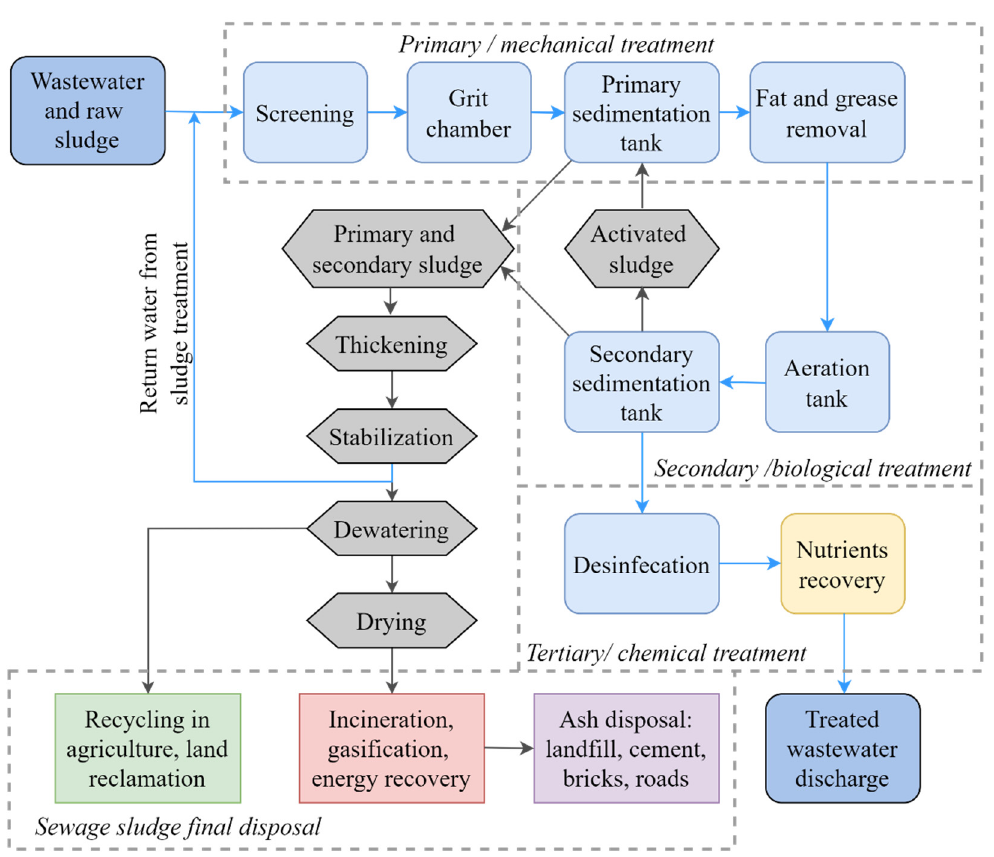
Figure 1. Wastewater and sewage sludge treatment methods in the EU.